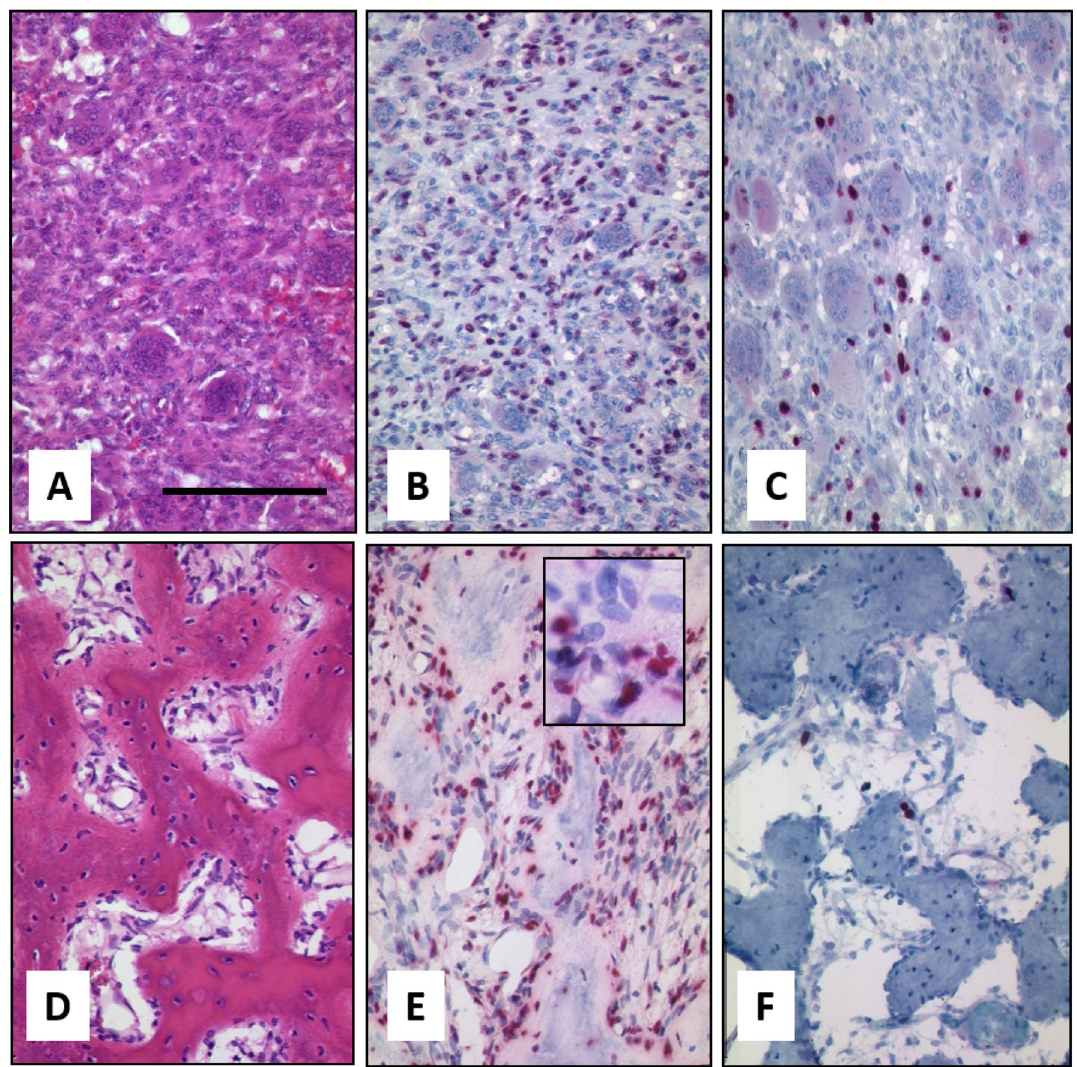
Figure 1. Morphology of Case 1. (A) Typical GCTB with osteoclastic giant cells and intermingled mononuclear cells before therapy (bar = 100 µm). Neoplastic mononuclear cells are positive in a H3F3A G34W staining in the nuclei (B) and about 5% of cells are Ki-67 positive (C) . After denosumab therapy GCTB shows induction of neoformated osteoid and complete reduction of giant cells (D) , while H3F3A G34W-positive cells are